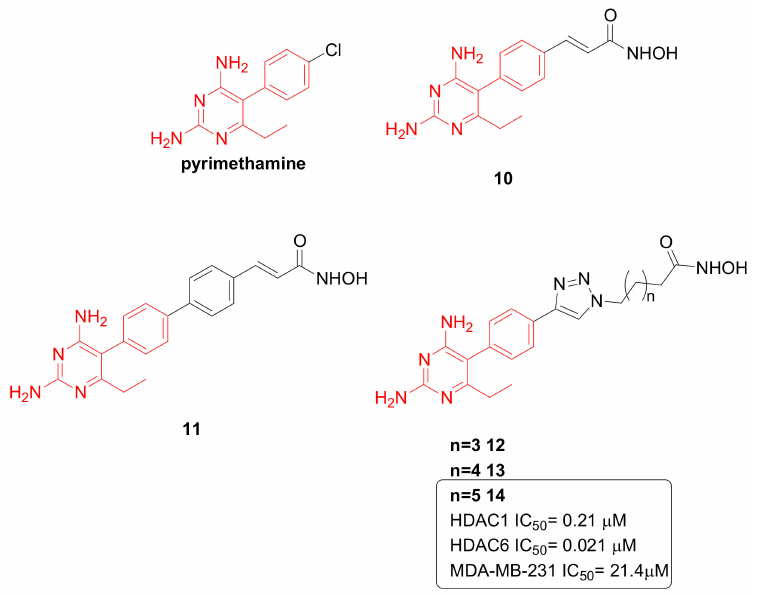
Figure 10. Chemical structures of HDAC/STAT3 inhibitors. Compound 14 had the ability to be directed quite selectively against HDAC6 and to impair TNBC